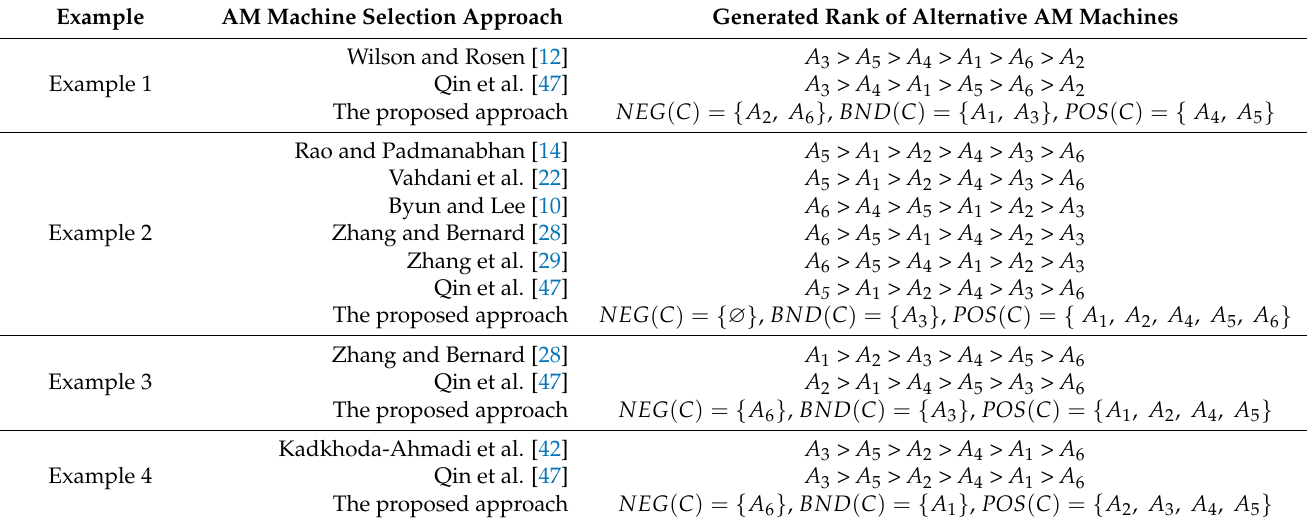
Table 13. Results of the comparison